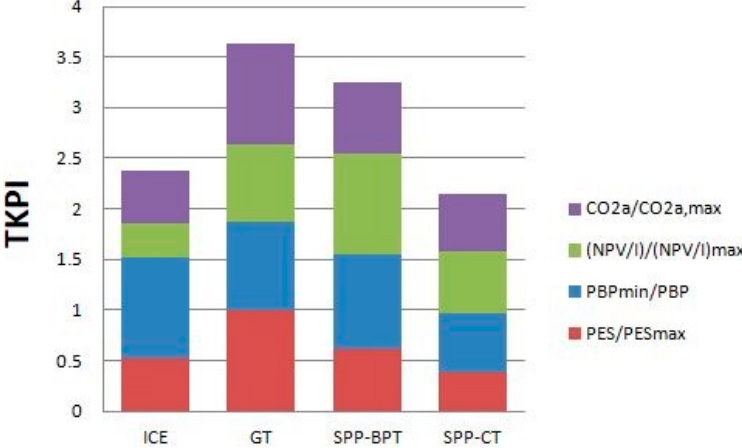
Figure 11. TKPI values and breakdown for the considered cogeneration technologies with white certificates taken into account (optimal design).